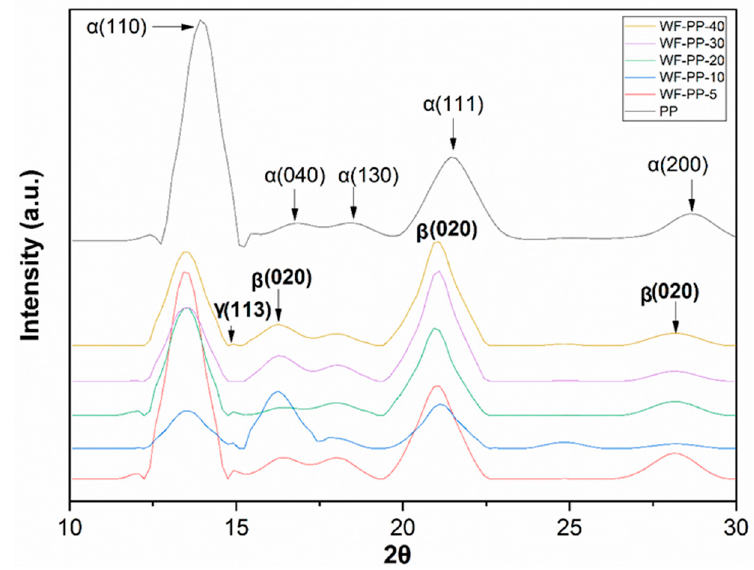
Figure 6. X-ray di ff raction patterns of PP and WF-PP Figure 6. X ‐ ray diffraction patterns of PP and WF ‐ PP composites.